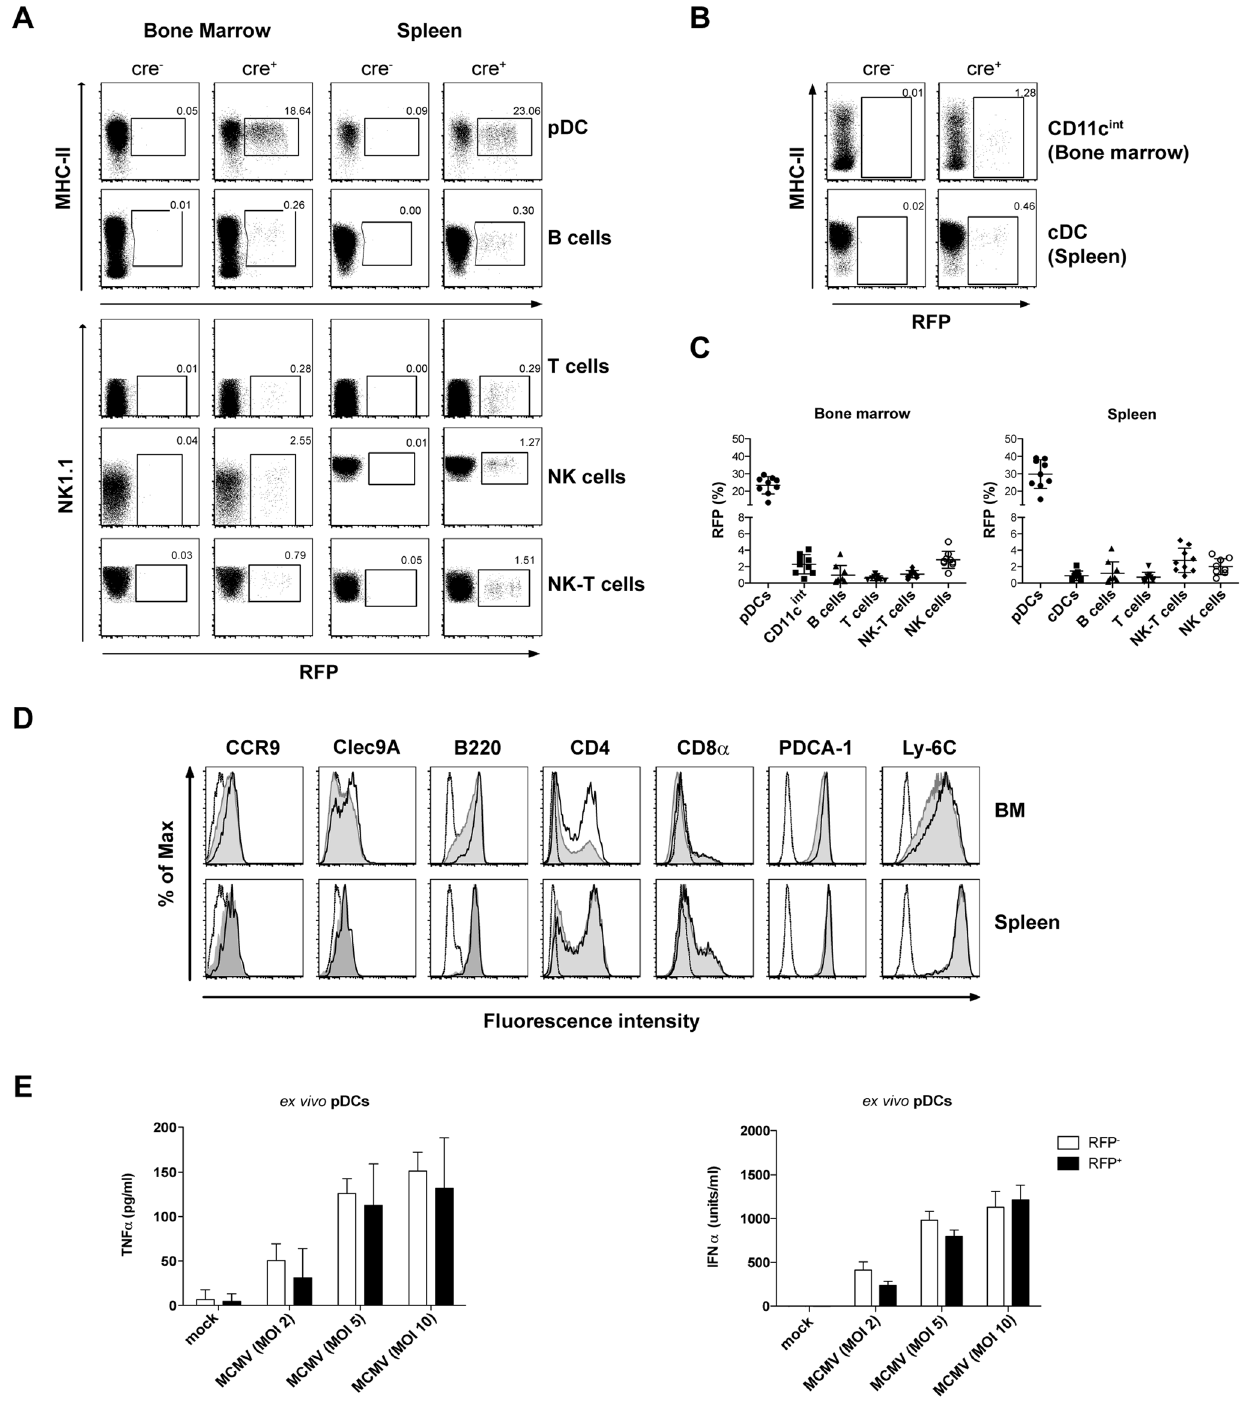
Figure 1. Characterization of the pDCre x RFP reporter line shows terminal targeting of pDCs. ( A, B ) BM and spleen cells from pDCre x RFP mice were stained for Siglec-H, CD11c, MHCII, CD3 e , CD19 and NK1.1 ( A ) Characterization of the reporter expression (RFP) by different cell types: pDCs were gated as Siglec-H + , B cells as Siglec-H 2 CD19 + CD3 e 2 NK1.1 2 , T cells as Siglec-H 2 CD19 2 CD3 e + NK1.1 2 , NK-T cells as Siglec-H 2 CD19 2 CD3 e + NK1.1 + , and NK cells as Siglec-H 2 CD19 2 CD3 e 2 CD11c int NK1.1 + . FACS plots are representative for two individual experiments. ( B ) Characterization of the RFP reporter expression by CD11c hi MHCII hi cDCs in spleen and CD11c int CD19 2 CD3 e 2 NK1.1 2 Siglec-H 2 cells in BM. ( C ) Quantification of (A, B) showing pooled data from 2 independent experiments using 4–5 mice/group. ( D ) Phenotypic comparison of pDC markers expressed by RFP 2 and RFP + pDCs from BM (top panel) and spleen (bottom panel). pDCs were gated as Siglec-H + CD11c int . Histogram overlays display the isotype controls as dashed line, and the marker expression by RFP 2 pDCs as grey filled histogram and by RFP + pDCs as bold line. Data shown are from one representative experiment out of two using 4 mice/group. ( E ) Splenic ex vivo pDCs were purified by FACS sorting from B16-Flt3L treated pDCre x RFP mice and incubated with the indicated MOIs of MCMV in vitro . IFN a /TNF a concentrations were quantified in the supernatants after 24 h incubation by ELISA or cytometric bead assay. Data shown are from one representative experiment out of two using a pool of 3 mice. The differences between RFP 2 and RFP + pDCs were not significant as calculated by Students t-test. Data displayed in (D, E) are from one out of two individual experiments with similar results. Data are displayed as mean 6 SD. doi:10.1371/journal.ppat.1003648.g001 PLOS Pathogens |